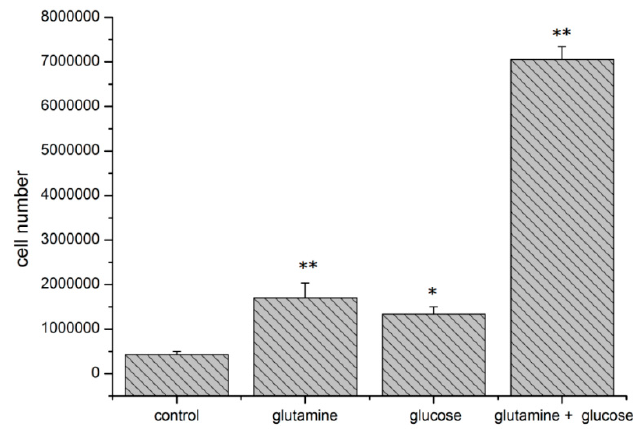
Figure 10. E ff ect of glutamine and glucose on the cell proliferation of MDA-MB-231 cells. One million Figure 10. Effect of glutamine and glucose on the cell proliferation of MDA ‐ MB ‐ 231 cells. One million cells were cultured in DMEM (with or without glucose and / or glutamine) containing 10% fetal bovine cells were cultured in DMEM (with or without glucose and/or glutamine) containing 10% fetal bovine serum (1) without glucose or glutamine, (2) with 5 mM glutamine, (3) with 11.1 mM glucose, and (4) with 5 mM glutamine and 11.1 mM glucose for 72 h. Then, the cells were counted. Compared to the single application of either substance, the use of both glutamine and glucose resulted in rapid cell proliferation. (* - p -value < 0.05; ** - p -value < 0.01, Student t -test as compared to